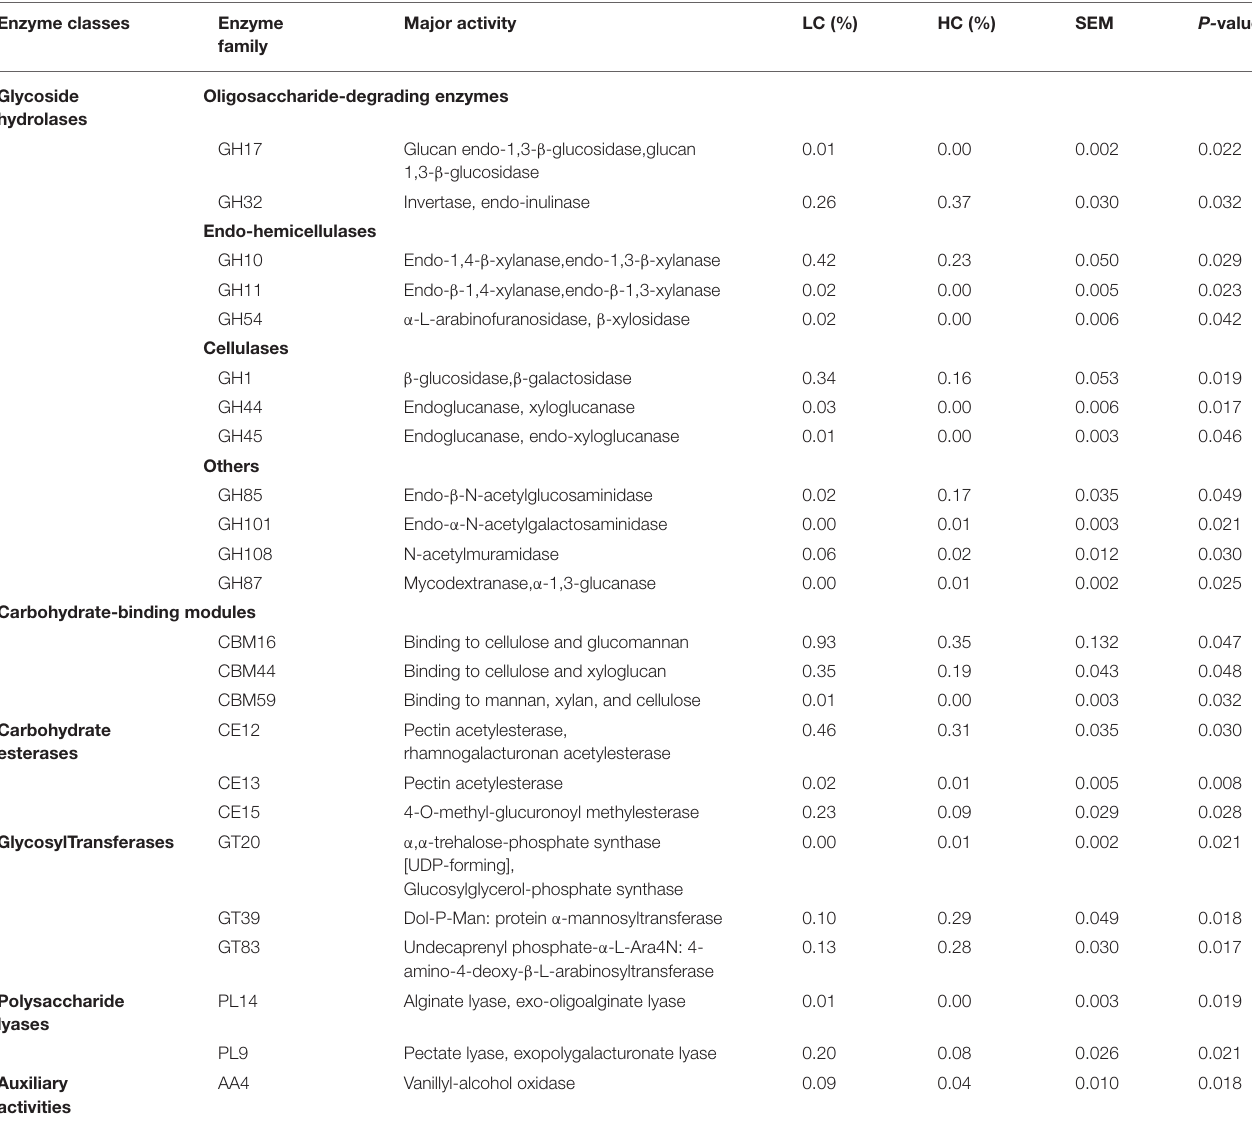
TABLE 1 | The effects of high-concentrate (HC) diets on the relative abundance of abundant carbohydrate-active enzymes ( > 0.01% in at least one group) in the fecal samples of dairy cows. Enzyme classes